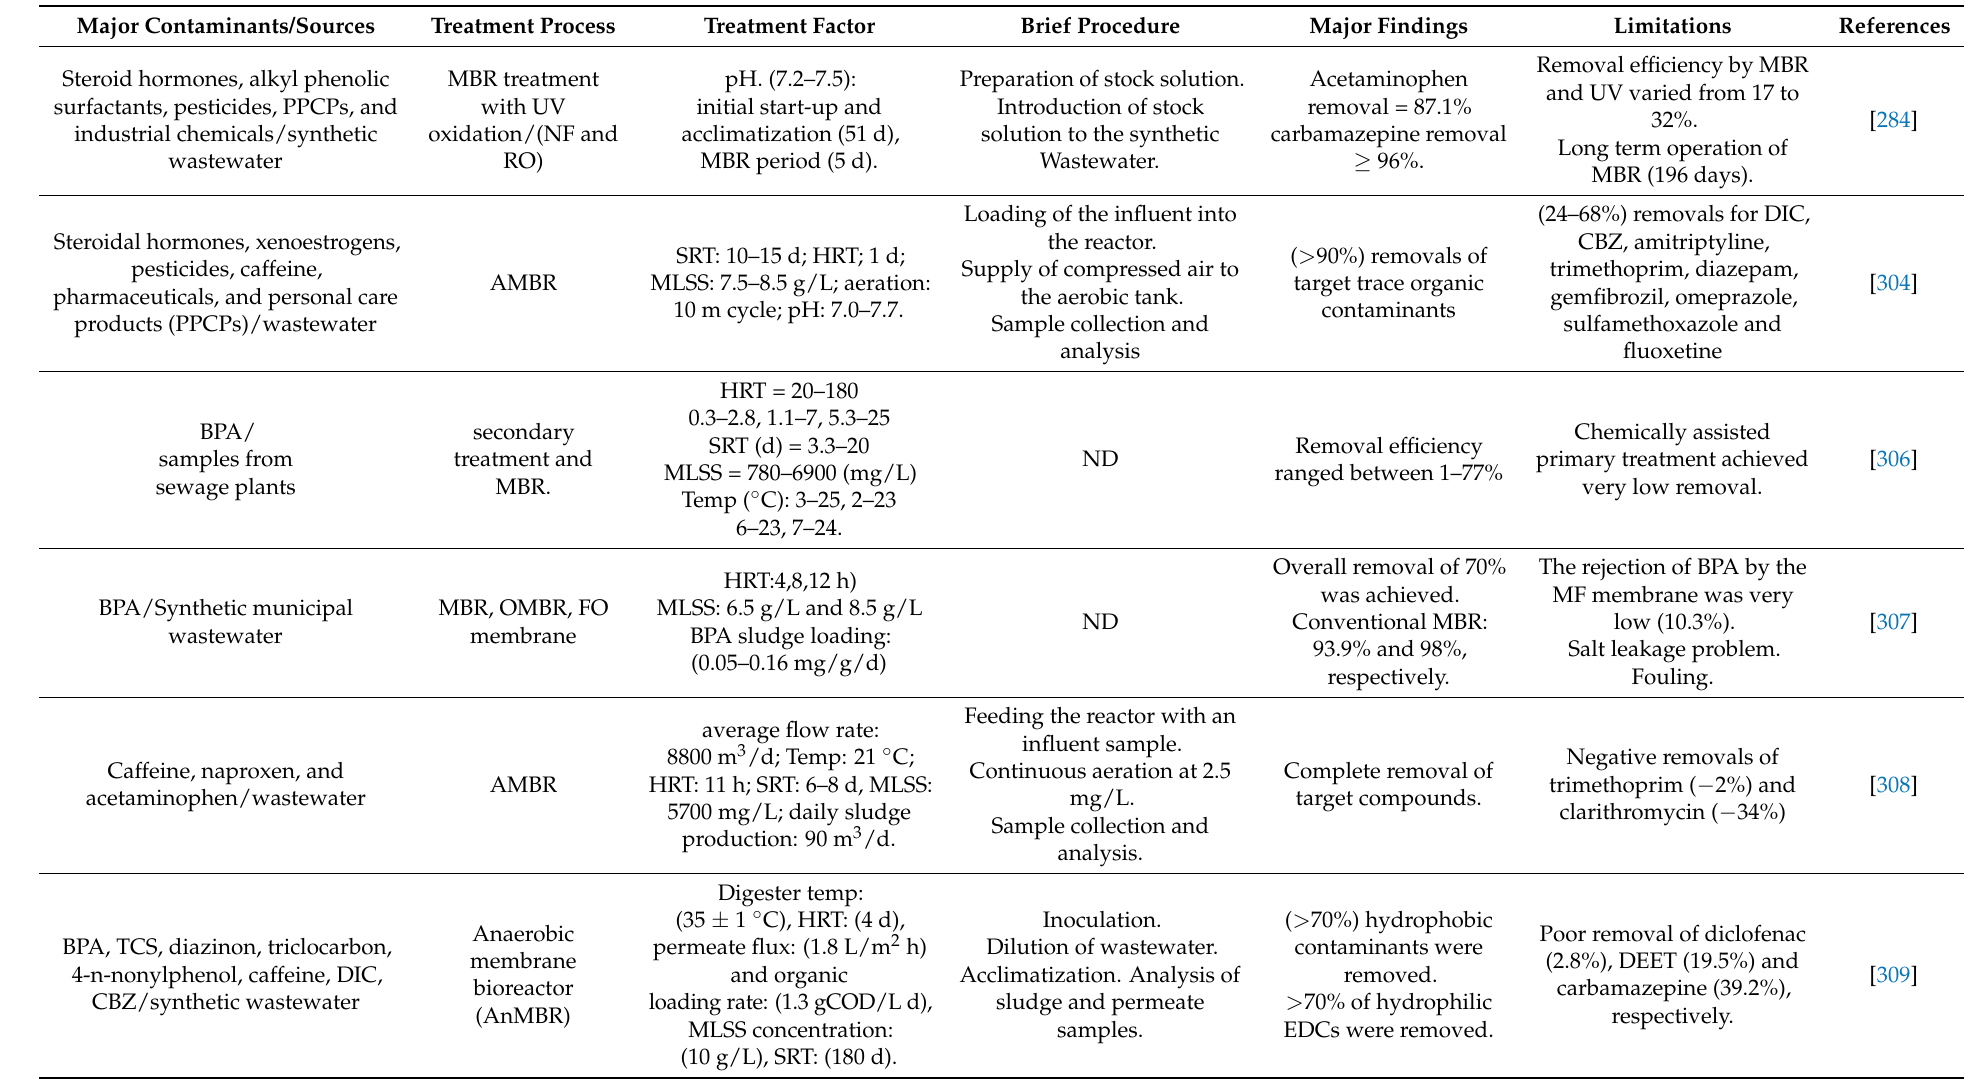
Table 5. Removals of some endocrine-disrupting compounds during MBR